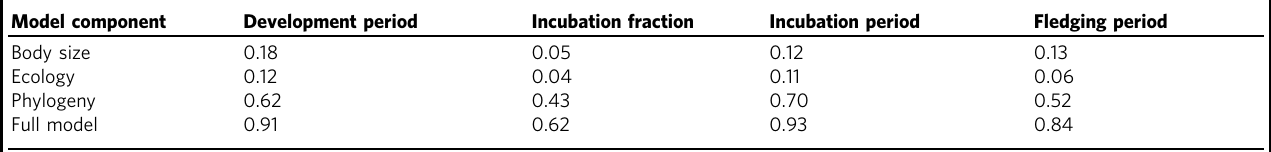
Table 1 R 2 values for model components explaining variation in avian developmental durations. Model